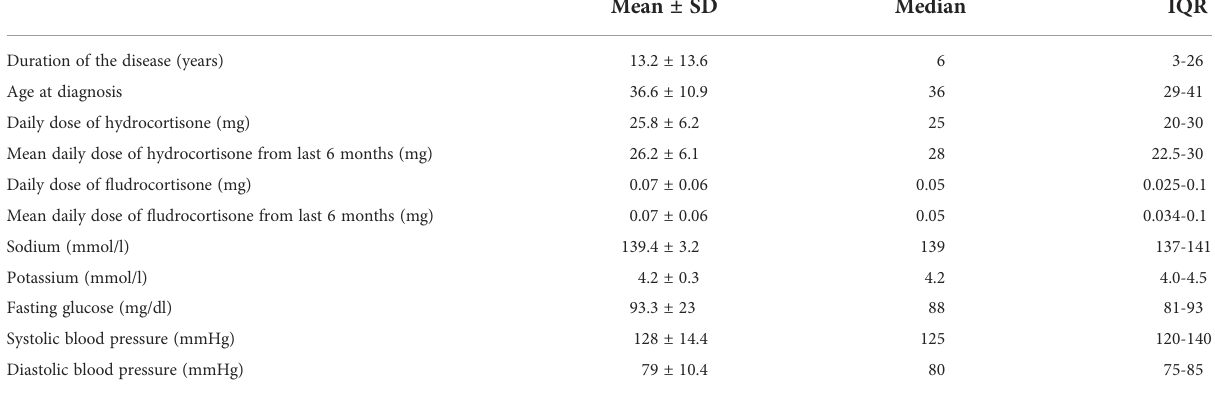
TABLE 2 Characteristics of the patients with autoimmune primary adrenal insuf fi ciency (n = 29).